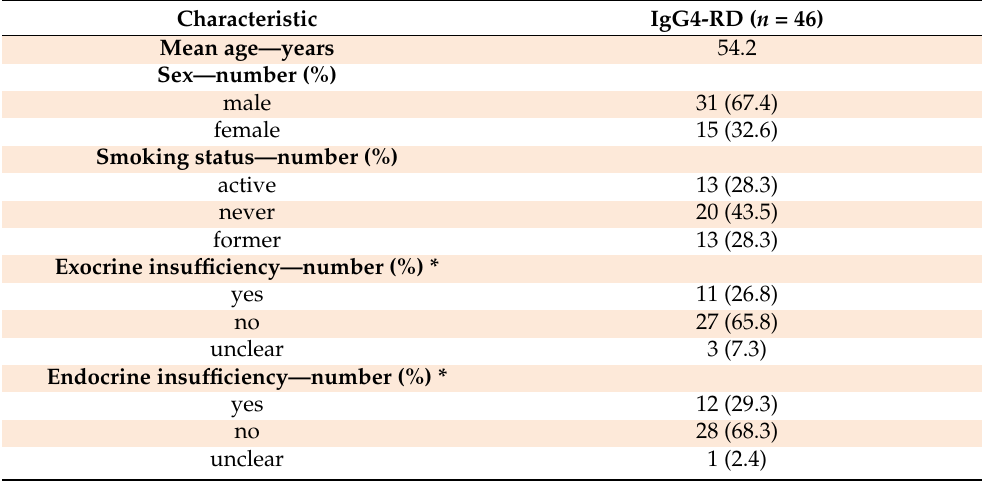
Table 1. Characteristics of patients with IgG4-related disease at baseline. Exocrine and endocrine insufficiency during follow-up.